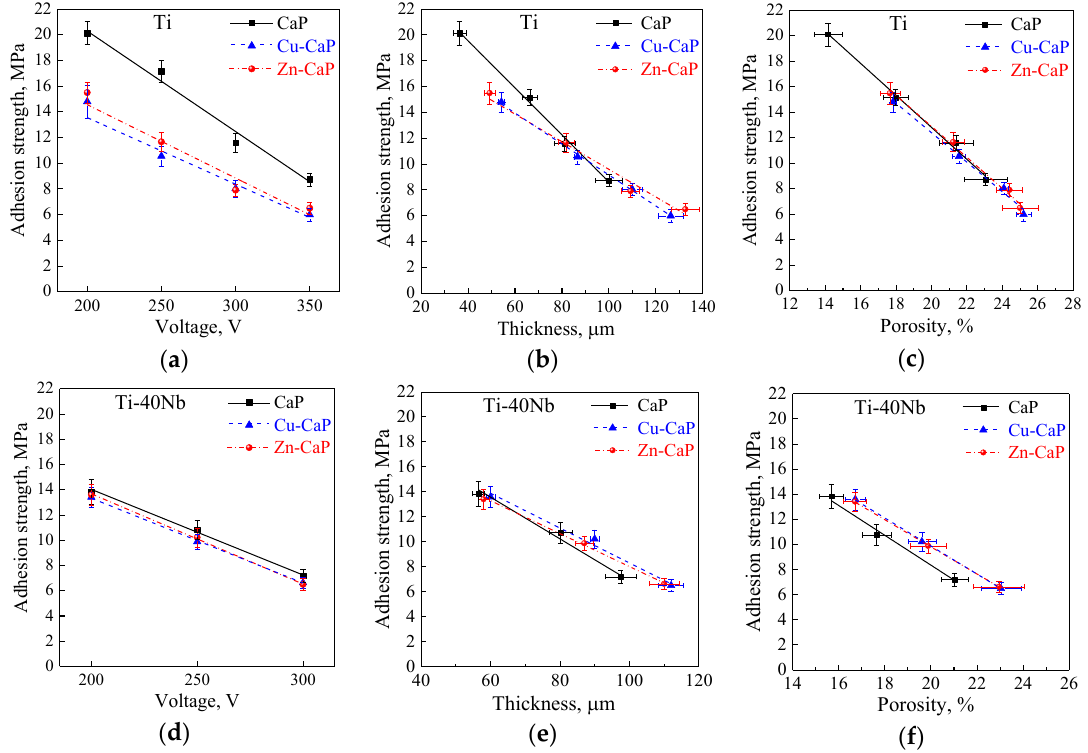
Figure 5. Plots of the adhesion strength of all the types of coatings on both Ti ( a – c ) and Ti-40Nb ( d – f ) substrates against the applied voltage ( a,d ), the coating thickness ( b,e ) and surface porosity ( c,f ).